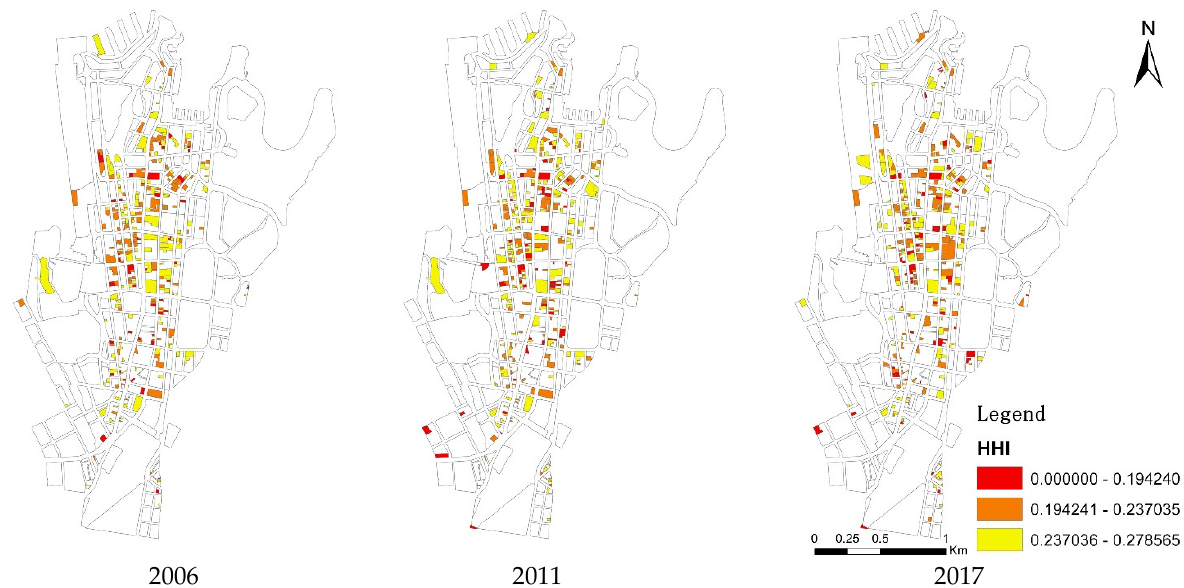
Figure 5. Heterogeneity of individual buildings, calculated using the HHI index (red colours indicate a higher diversity of industries within buildings). Notes: analysis of in-building heterogeneity showed a dispersed pattern of buildings with high heterogeneity from 2006–2017; nevertheless, it showed intense clustering along George Street and Pitt Street, in the finance and retail districts.